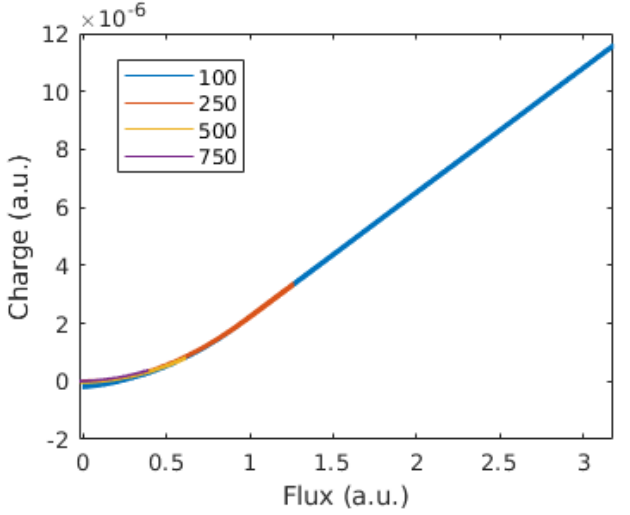
Figure 7. Q − φ characteristics of the memristor implemented using Figure 4. The different frequen- cies (in arbitrary units) are shown in different colors.